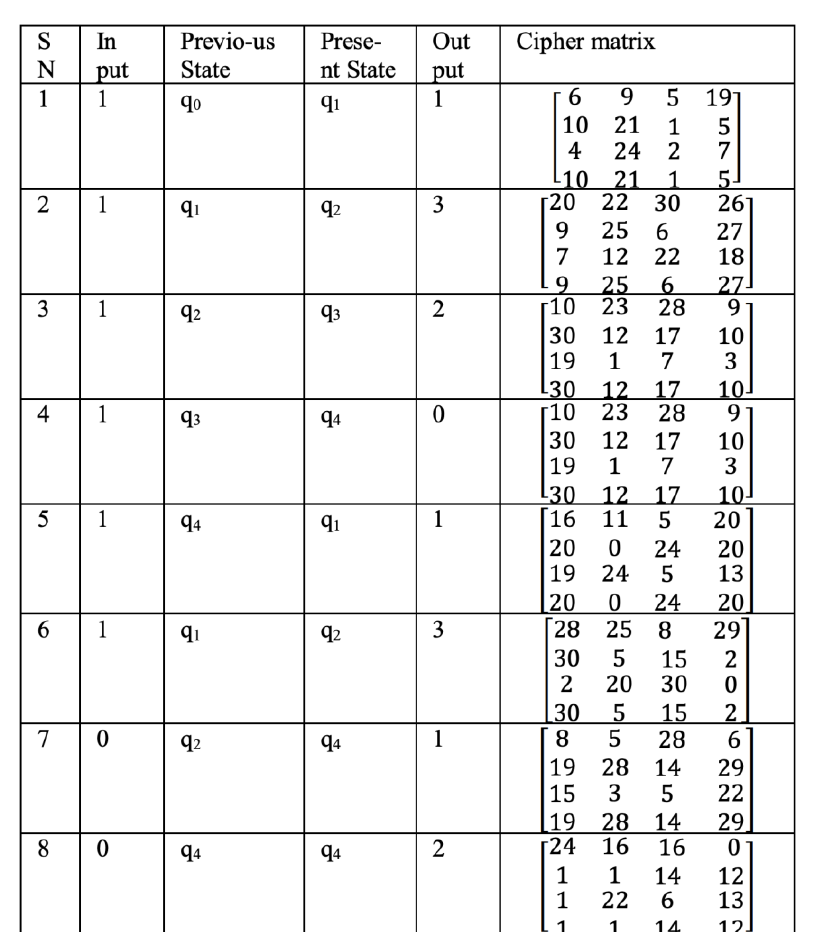
Table 2. Cipher matrix at each